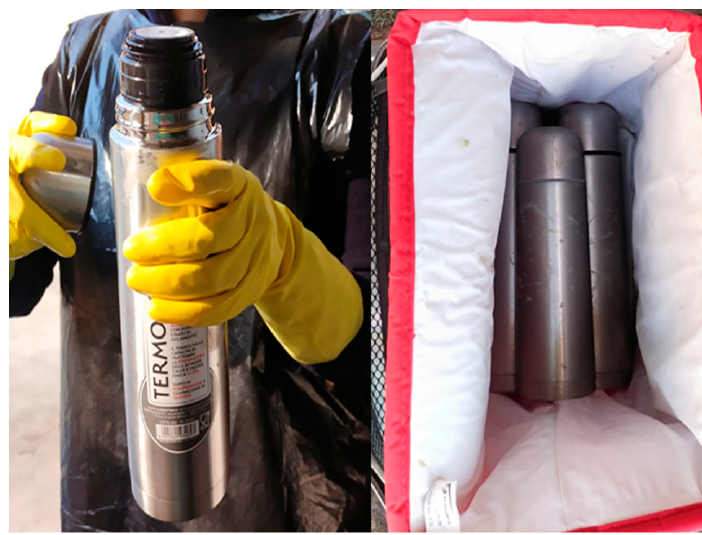
Figure 2. Squeezing and collection of RF at slaughterhouse.